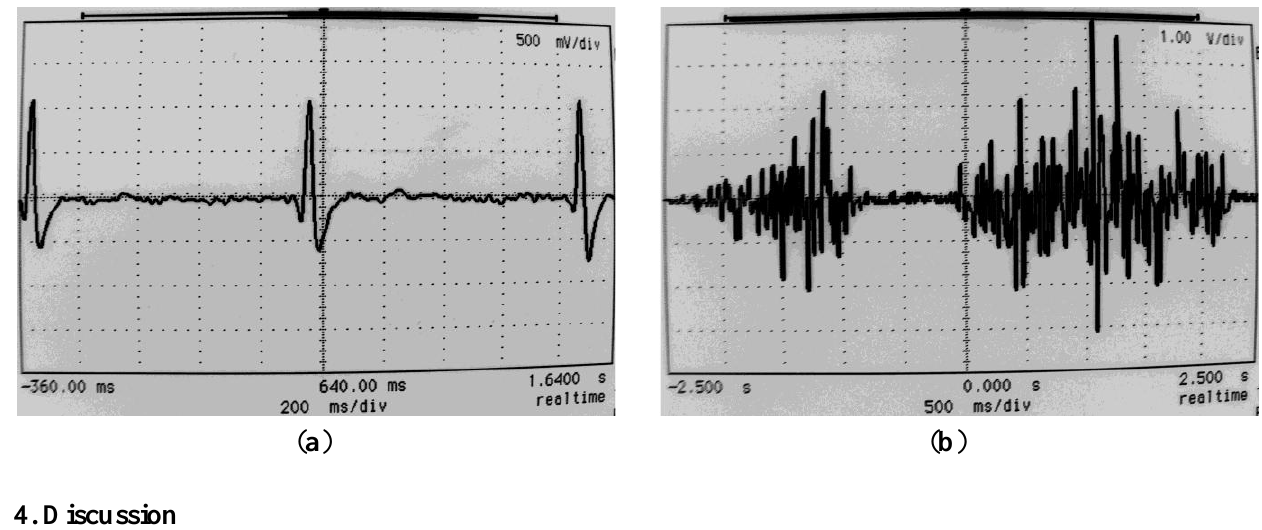
Figure 10. Sample biopotential recordings performed with the test circuit in Figure 5 at the ( b ) An extensor carpi radialis longus